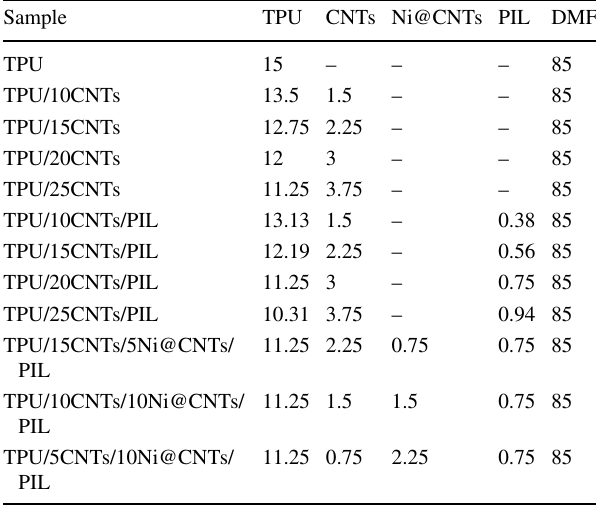
Table 1 Formulation of TPU composite